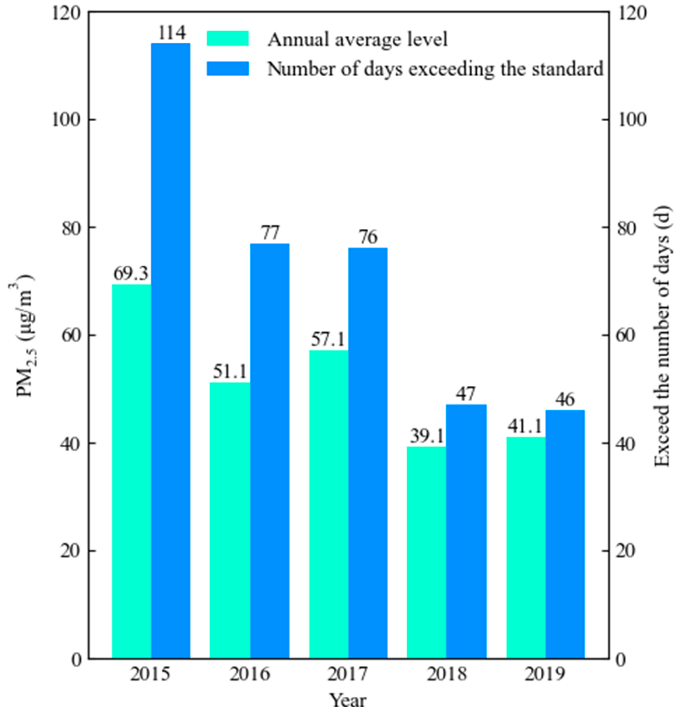
Figure 7. Histogram of PM 2.5 pollution over time.